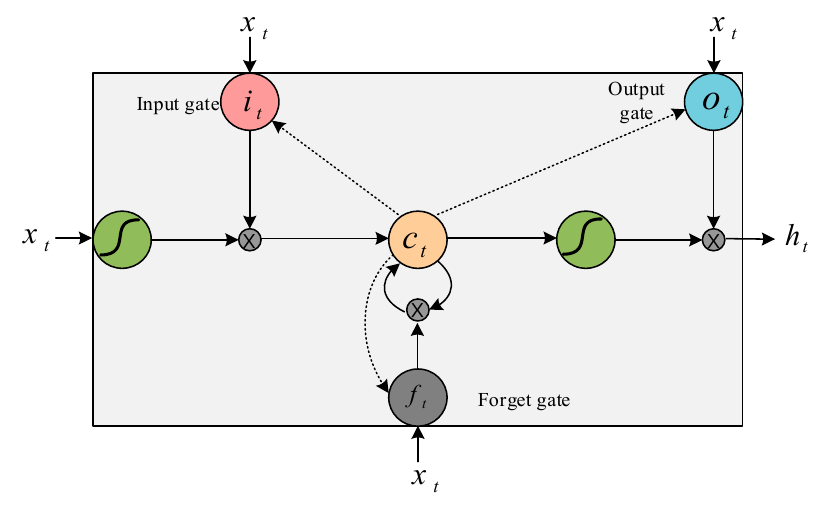
Figure 3. LSTM unit structure.